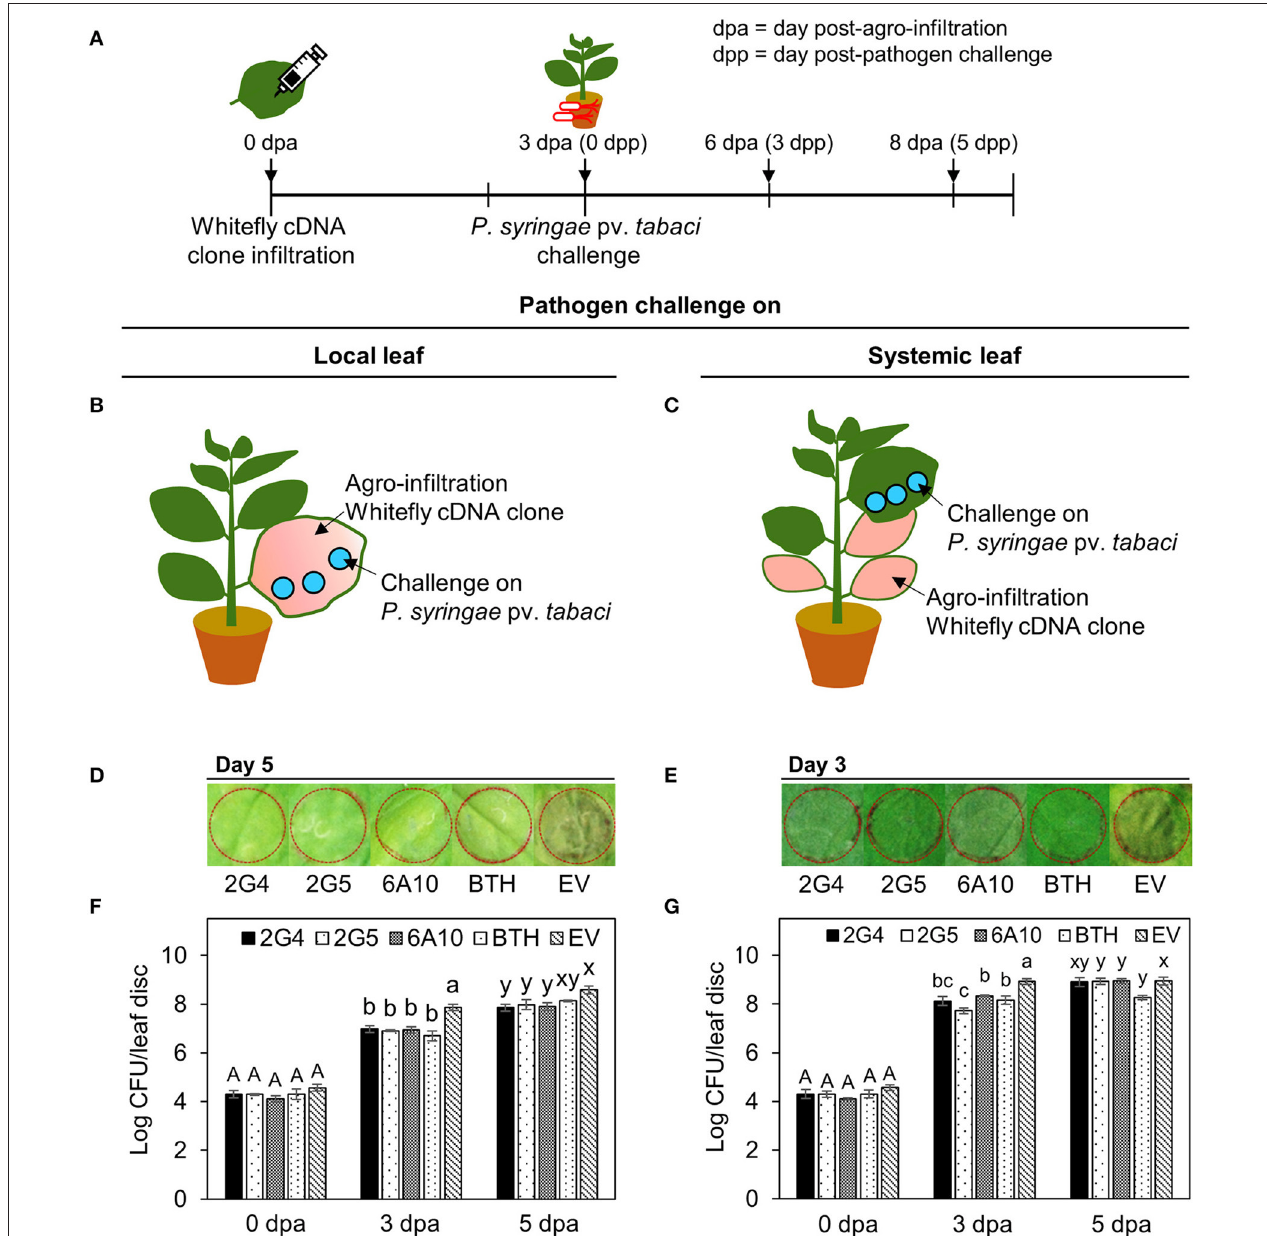
FIGURE 2 | Systemic acquired resistance against P. syringae pv. tabaci elicited by candidate whitefly effectors on local and systemic tobacco leaves. (A) Schematic diagram of the experimental design for investigating SAR against Pta after leaf infiltration with whitefly cDNA clones 2G4, 2G5, and 6A10. (B) SAR against Pta in a local tobacco leaf. A suspension of Pta at OD 600 = 0.001 was infiltrated into a tobacco leaf that had been pre-infiltrated with whitefly cDNA clones 2G4, 2G5, and 6A10 throughout the leaf at 3 days before pathogen challenge. (C) SAR against Pta on a systemic tobacco leaf. A suspension of Pta at OD 600 = 0.001 was infiltrated into a whole tobacco leaf that had been pre-infiltrated with whitefly cDNA clones 2G4, 2G5, and 6A10 at 3 days before pathogen challenge using a needleless syringe. (D) Disease symptom development at 5 days after pathogen challenge on local leaf. (E) Disease symptom development at 3 days after pathogen challenge on systemic leaf. (F) Bacterial population size of local leaf were measured at 0, 3, and 5 days after Pta infiltration with a needleless syringe. (G) Bacterial population size of systemic leaf were measured at 0, 3, and 5 days after Pta infiltration. Bars represent the mean value ± SEM ( N = 10). Infiltration with 1mM BTH and Agrobacterium empty vector (EV) suspension was used as a positive and negative control, respectively. Different letters (a, b, and c; x and y) within day indicate statistically significant differences ( P < 0.05).